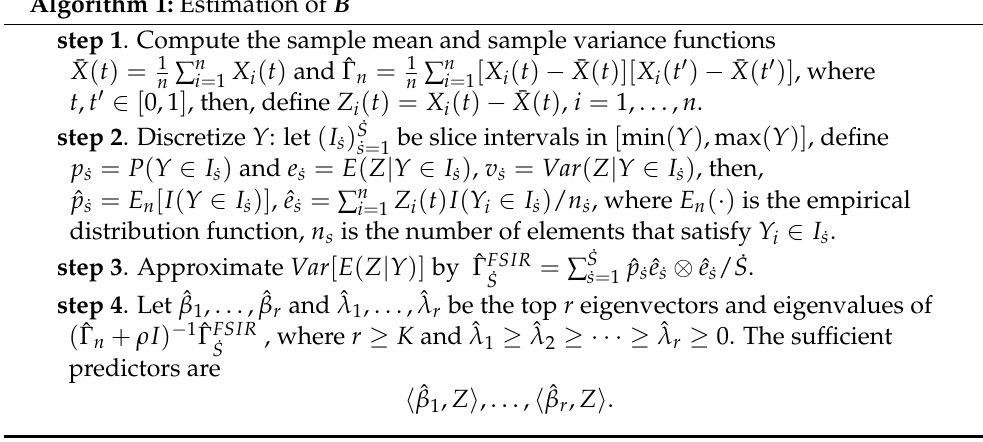
Algorithm 1: Estimation of